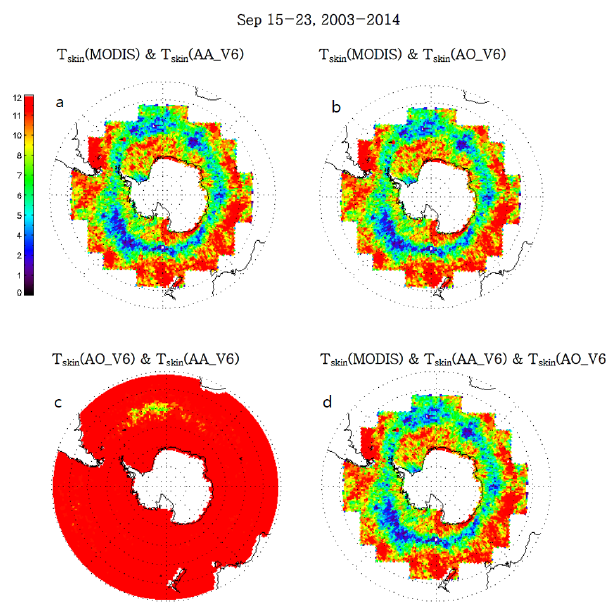
Figure 2. The number of co-located observations of (a) T skin (MODIS) and T skin (AA_V6), (b) T skin (MODIS) and T skin (AO_V6), and (c) T skin (AO_V6) and T skin (AA_V6) over the Southern Hemisphere during 15–23 September 2003–2014. (d) Same as in (c) except for three different data sets ( T skin (MODIS), T skin (AA_V6), and T skin (AO_V6)).